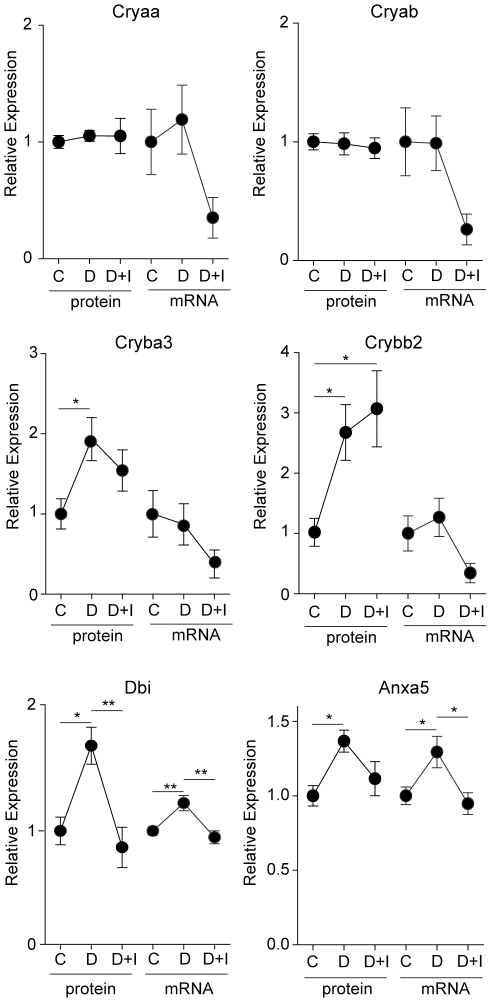
Responsiveness of protein expression to insulin therapy.To examine the effect of insulin treatment on protein and mRNA expression for those targets confirmed in the previous experiments, an independent animal experiment was performed with the addition of an insulin-treated diabetic group that received insulin for 1.5 months after 1.5 months of diabetes without insulin therapy. Increased retinal protein expression of Cryba3, Crybb2, Dbi, and Anxa5 was again observed. Retinal Dbi protein expression was completely normalized by insulin treatment, while Cryba3 protein expression was partially normalized. Crybb2 expression remained elevated following 1.5 months of insulin treatment. The previously observed elevations in Cryaa and Cryab were not recapitulated in this set of animals. C = Control, D = Diabetic, D+I = Diabetic with insulin, * p<0.05, ** p<0.01, one-way ANOVA, Student Newman Keuls post-hoc test.